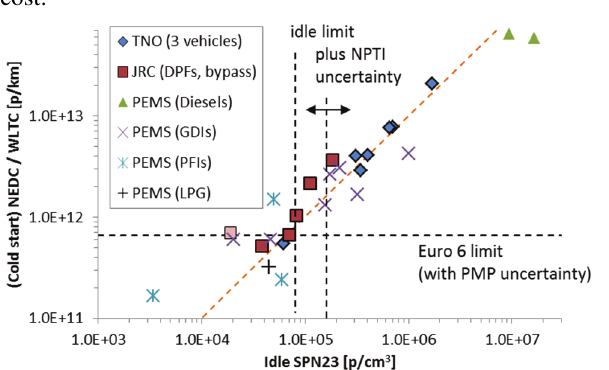
Fig. 9. Emission factor (#/km) during NEDC or WLTC vs raw exhaust concentration (#/cm 3 ) measured during low idle with different PMP or SPN-PEMS instruments based on the PEMS project (Chapter 4). TNO data from [56]. JRC data and NPTI uncertainty estimation from